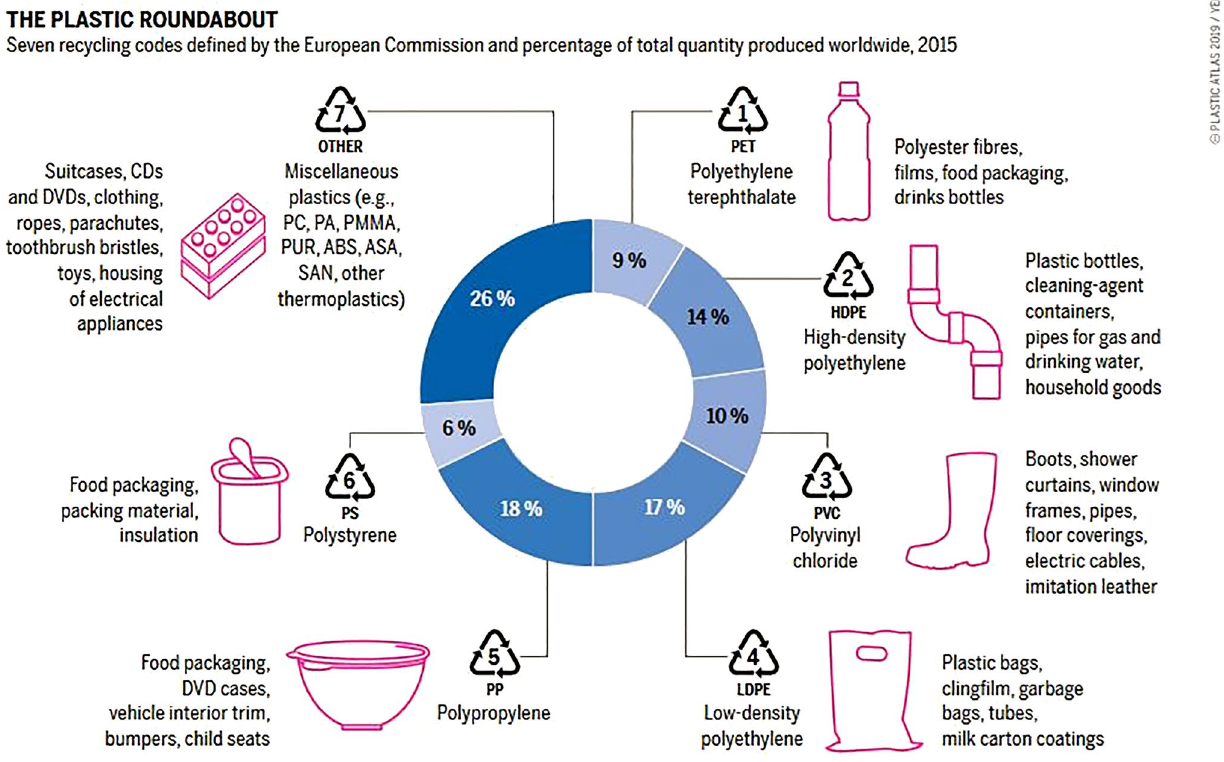
Fig. 1 Plastic Roundabout in Germany 2017